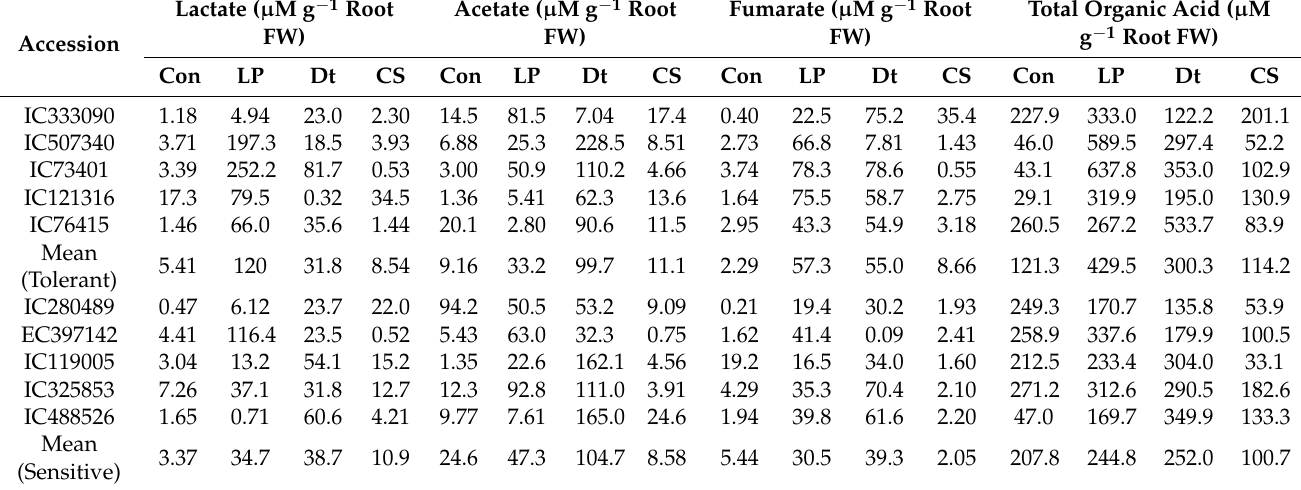
Table 5. Effect of P nutrition and drought on exudation of organic acids (lactate, acetate, fumarate, and total organic acid) from roots of selected mungbean accessions grown at two P levels (sufficient, 25.6 mg P kg − 1 dry soil, and low P, 7.8 mg P kg − 1 dry soil) and two moisture regimes (irrigated and drought). ‘nd’—not detectable; Con—Control; LP—Low phosphorus; Dt—Drought; CS—combined